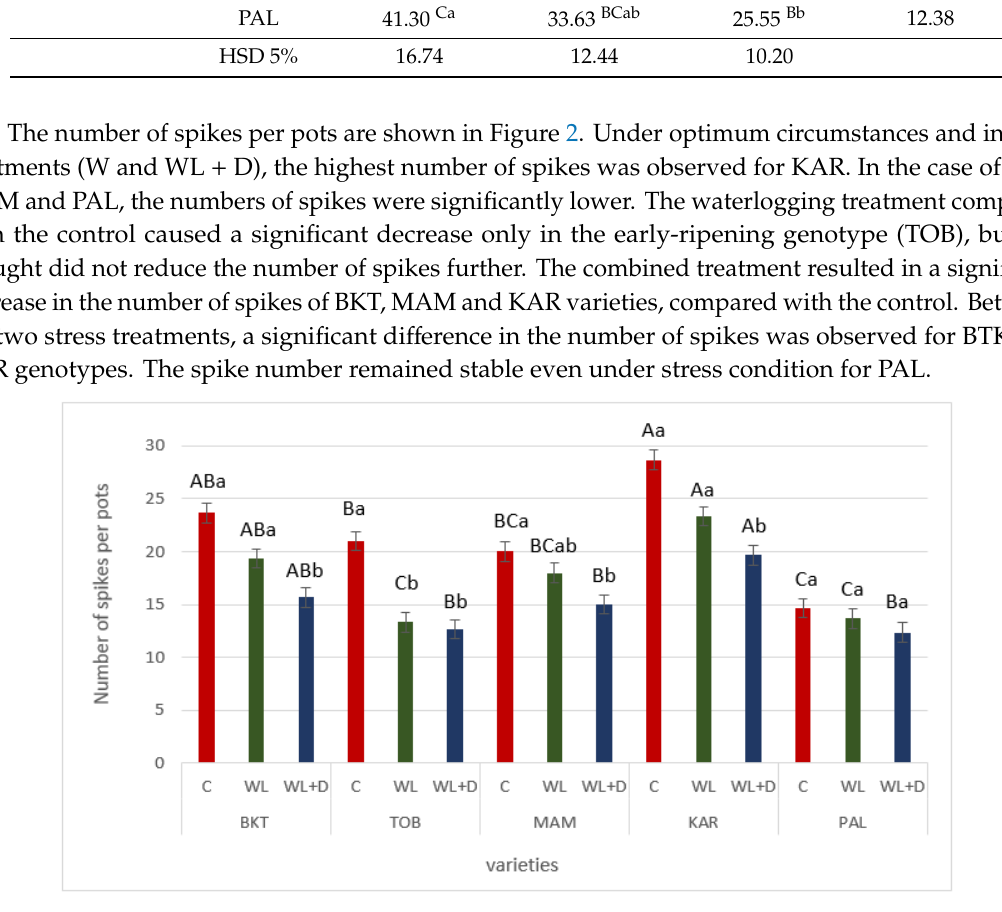
Figure 2. Number of spikes per pots of ‘Bánkúti 1201’ (BKT), ‘Mv Toborzó’ (TOB), ‘Mv Mambó’ (MAM), ‘Mv Karizma’ (KAR) and ‘Mv Pálma’ (PAL) varieties in the different treatments. ‘C’: control treatment; ‘WL’: waterlogging treatment; ‘WL + D’: combined treatment of waterlogging and drought. Capital letters indicate the statistical significance between the varieties at P ≤ 0.05 level; lowercase letters indicate the statistical significance between the treatments at P ≤ 0.05. Error bars represent honestly significant difference (HSD) 5% values (n = 3).